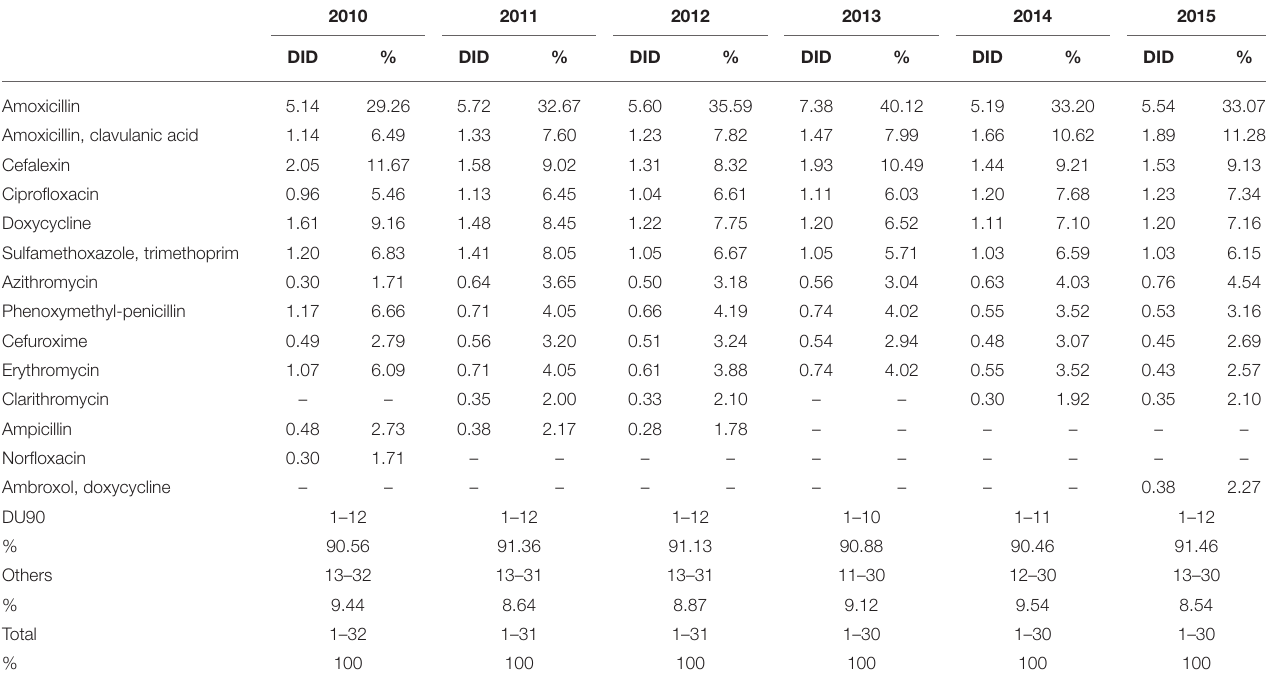
TABLE 3 | Antibiotic utilization within Drug Utilization (DU90%) profile, expressed in DIDs from 2010 to